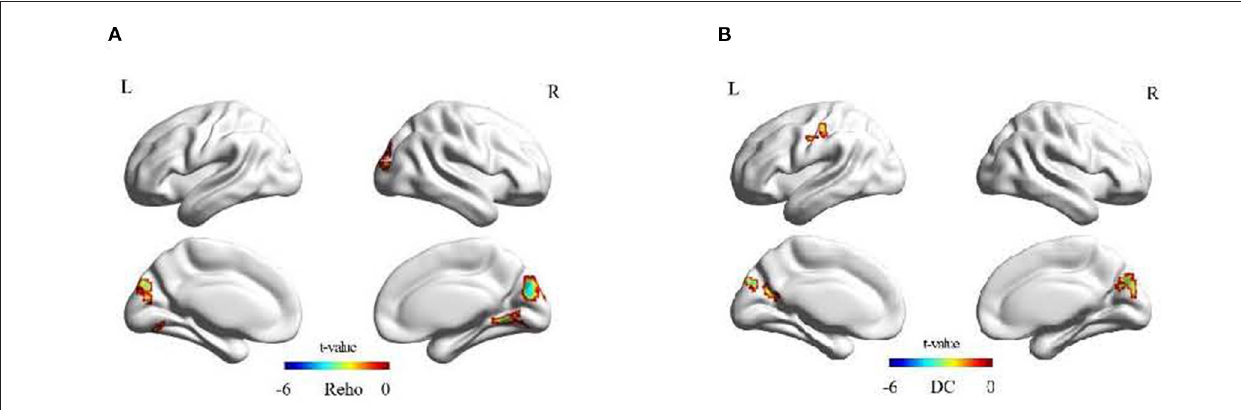
FIGURE 3 | Significant changes in the experimental group after rTMS. (A) Significant changes in ReHo values in the experimental group after rTMS. (B) Significant changes in DC values in the experimental group after rTMS. The color bar represents the t value of the paired t test. score ( r = 0.254, p = 0.05). The FC strength between the CUN.R and CUN.L was positively correlated with anxiety score on